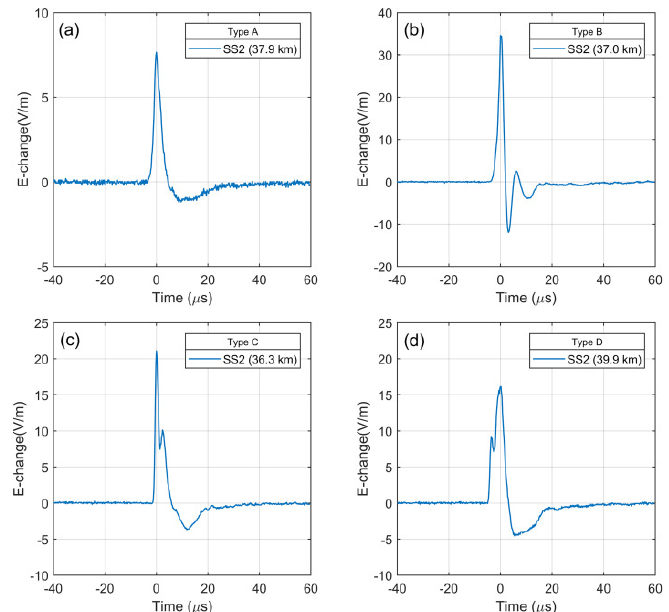
Figure 1 . Waveshapes of narrow bipolar pulses measured in the study conducted by Karunarathne et Waveshapes of narrow bipolar pulses measured in the study conducted by al. [6] and summarized in Bandara et al. [7]. ( a ) Example of a type A NBP, ( b ) example of a type B NBP, ( c ) example of a Type C NBP and ( d ) example of a type D NBP as defined in [6] and [7]—figure obtained from [7].